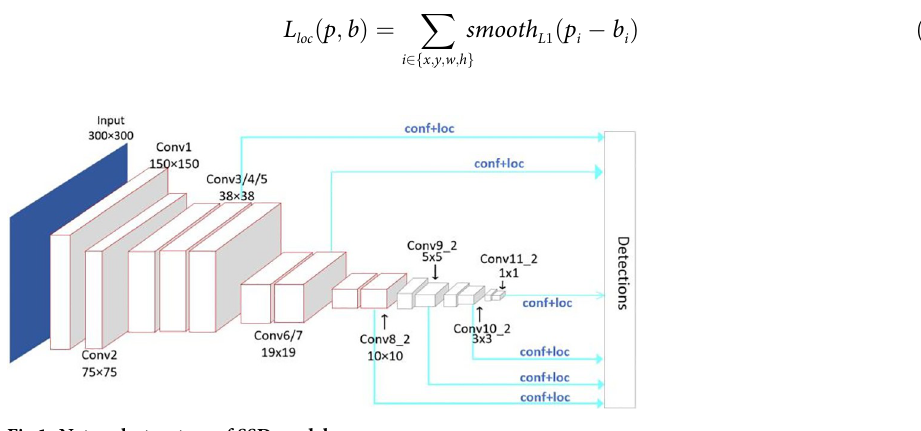
Fig 1. Network structure of SSD